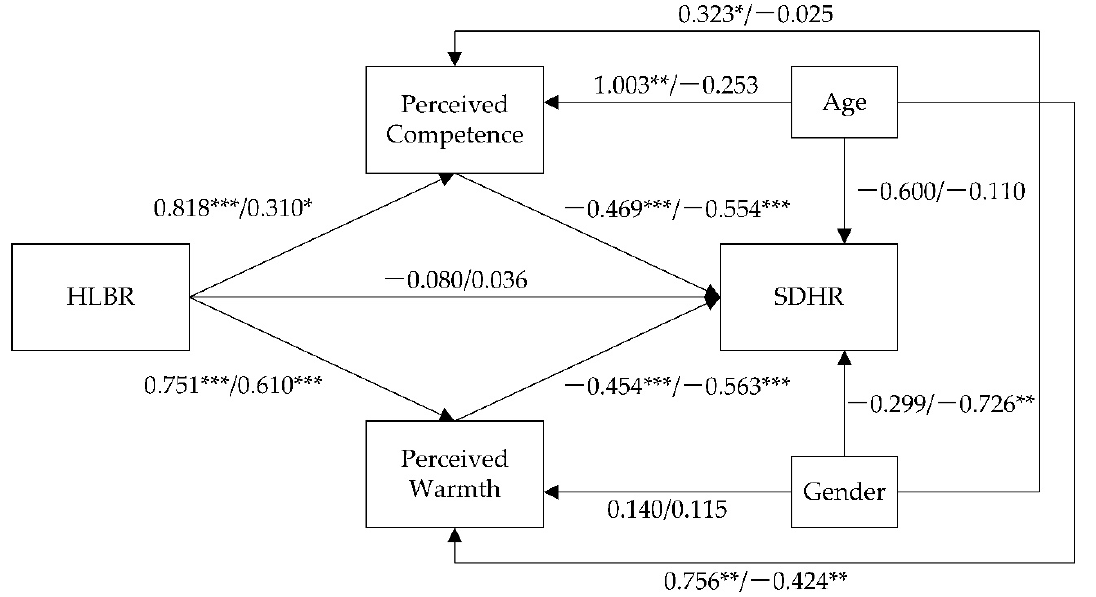
Figure 1. Results of mediation analysis. Note: Two coefficients on the path are China/US; * p < 0.05, ** p < 0.01, *** p < 0.001. Table 9. Comparison of variable means for Chinese and American participants. Variables